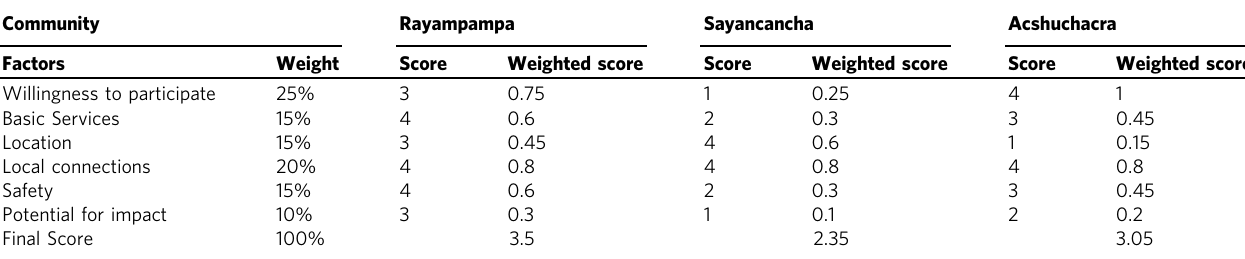
Table 3 Ranking factors of three pre-selected communities.